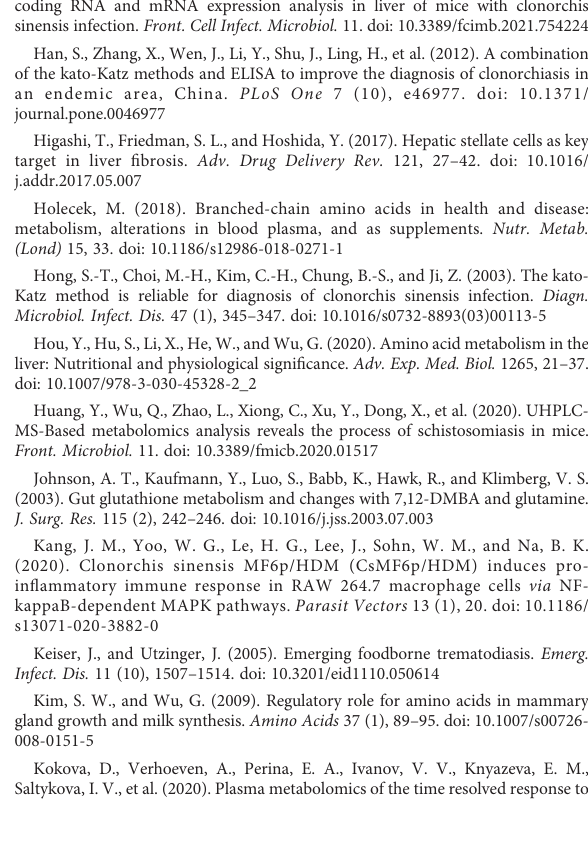
SUPPLEMENTARY FIGURE 1 C. sinensis eggs in feces of infected rats. SUPPLEMENTARY FIGURE 2 The level of serum ALT, AST and in fl ammatory factors in rat infected with Clonorchis sinensis . ALT, alanine aminotransferase; AST, aspartate transaminase; 4 wpi, 4 weeks post infection; 4 con, 4 weeks control; 8 wpi, 8 weeks post infection; 8 con, 8 weeks control. * P <0.05, ** P <0.01, *** P <0.001. SUPPLEMENTARY FIGURE 3 PCA score scatter plots of metabolites obtained from UHPLC-QTOF-MS in ESI+ mode (A-C) and ESI − mode (D-F). Each color represents a group, and each point represents a sample. 4 wpi, 4 weeks post infection; 4 con, 4 weeks control; 8 wpi, 8 weeks post infection; 8 con, 8 weeks control. SUPPLEMENTARY FIGURE 4 Venn diagrams displaying (comparatively) the differentially expressed metabolites. Differential metabolites across comparison groups showing unique and common metabolites in ESI+ mode (A) and ESI − mode